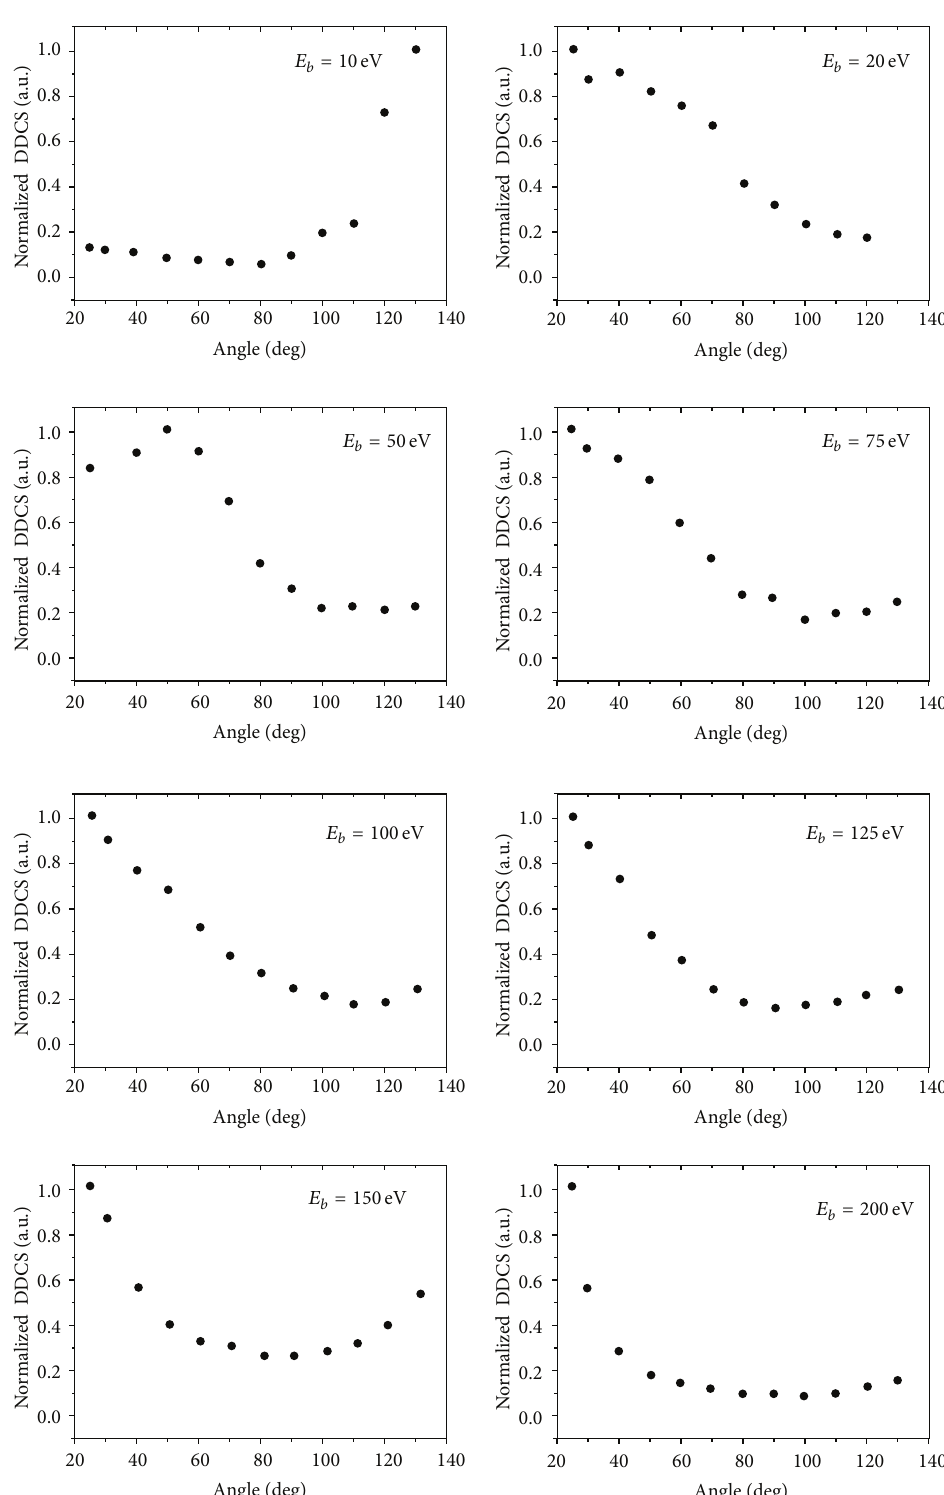
Figure 15: Present measurements of DDCS for Ar at 250 eV electron impact energy for 10–200eV detection electron